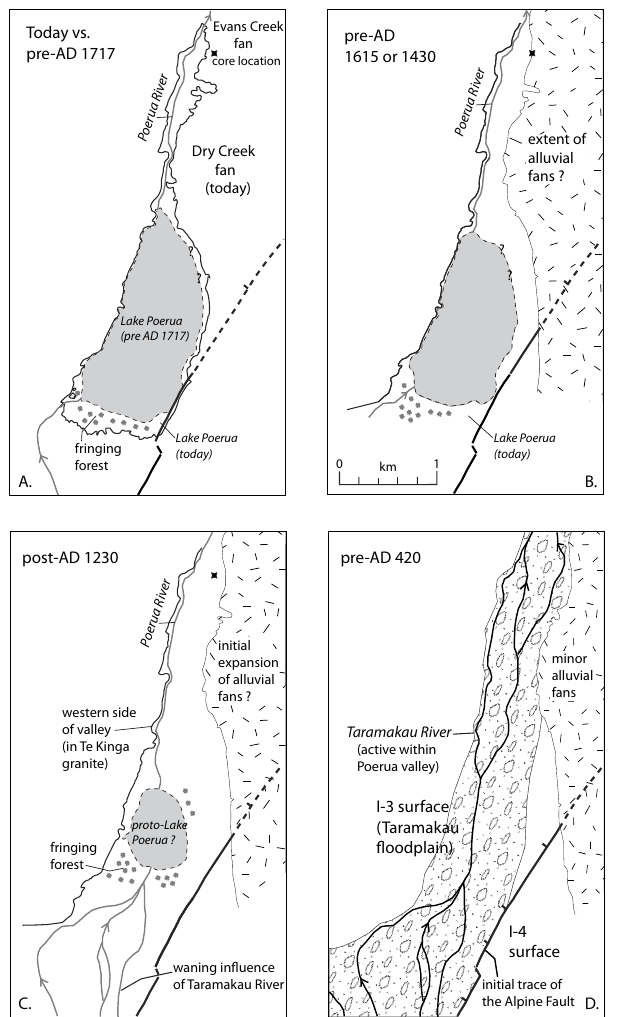
Fig. 10. Late Holocene history of Lake Poerua. (A) Lake Poerua as it occurs today (dark outline) and prior to the most recent Alpine Fault earthquake (light grey); (B) the lake as it appeared prior to the penultimate lake level rise. (C) proto-Lake Poerua as it may have existed near the time of the ca. 1230AD Alpine Fault earthquake; (D) the Poerua valley prior to AD 400 when the Taramakau River flowed within it. Bold lines represent the inferred presence of traces of the Alpine Fault at those